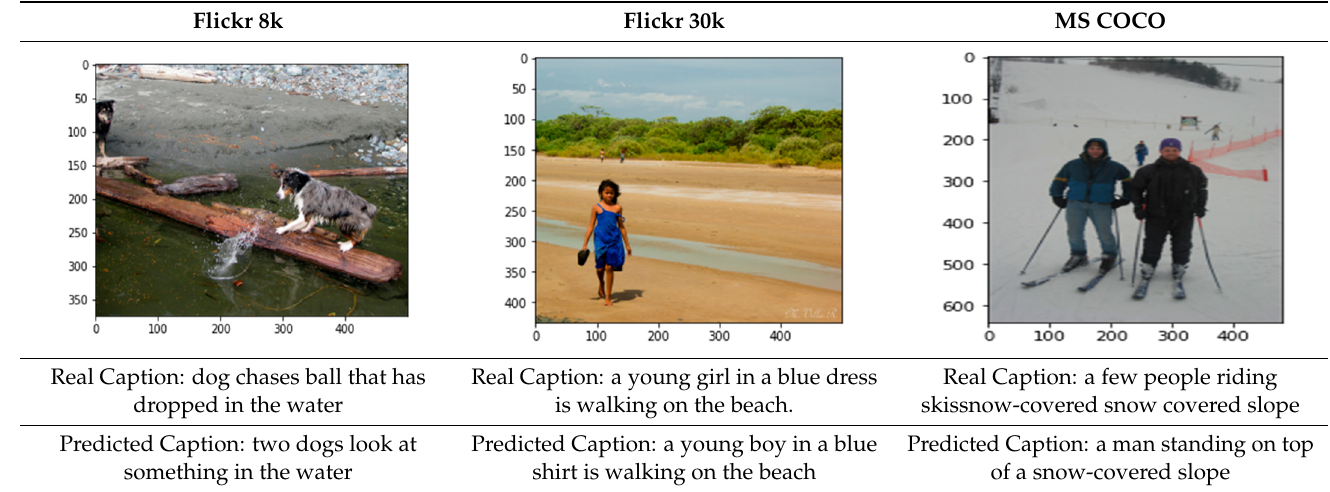
Table 6. Performance comparison based on different BLEU scores on Flickr 8k, Flickr 30k and MS COCO datasets using the encoder–decoder model and attention